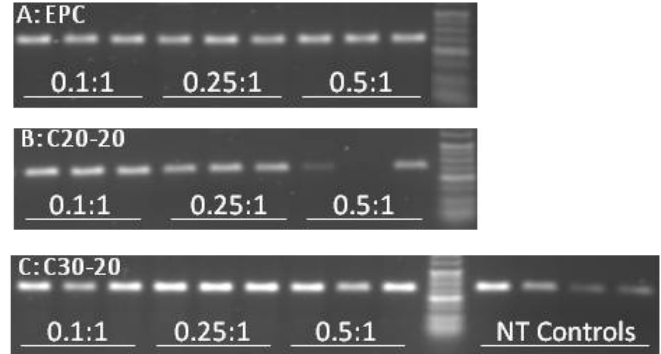
Figure 5. RT-PCR amplification of ribosomal 18s housekeeping gene to assess comparative RNA quality between samples transfected with various lipid/PMO AO complexes. 100 ng of RNA harvested from hSkMCs treated with lipoplex formulations, EPC/Chol/PMO, C20-20/Chol/PMO and C30-20/Chol/PMO at 250 nmol/L at the ratios indicated was subjected to RT-PCR amplification. The obtained products were separated by agarose gel (2.5%) electrophoresis against Hyper ladder V. The expected product is around 130 bp in